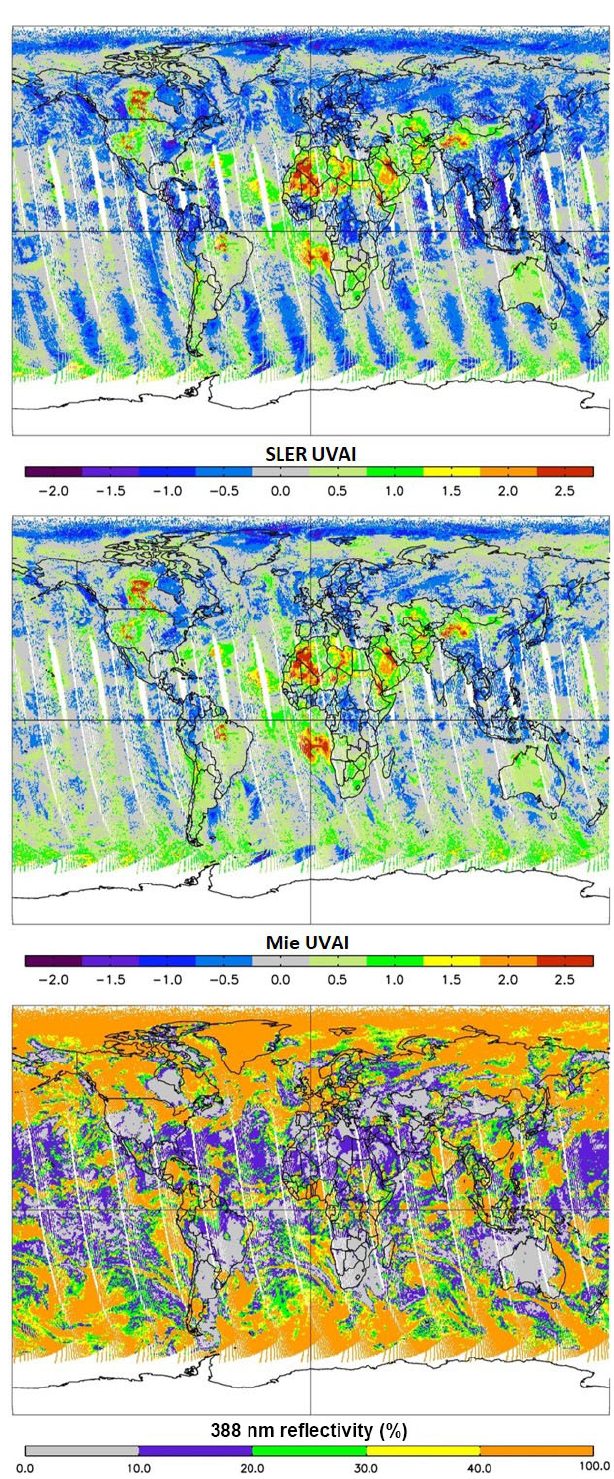
Figure 12. Global depiction of SLER UVAI, Mie UVAI and scene reflectivity on 20 August